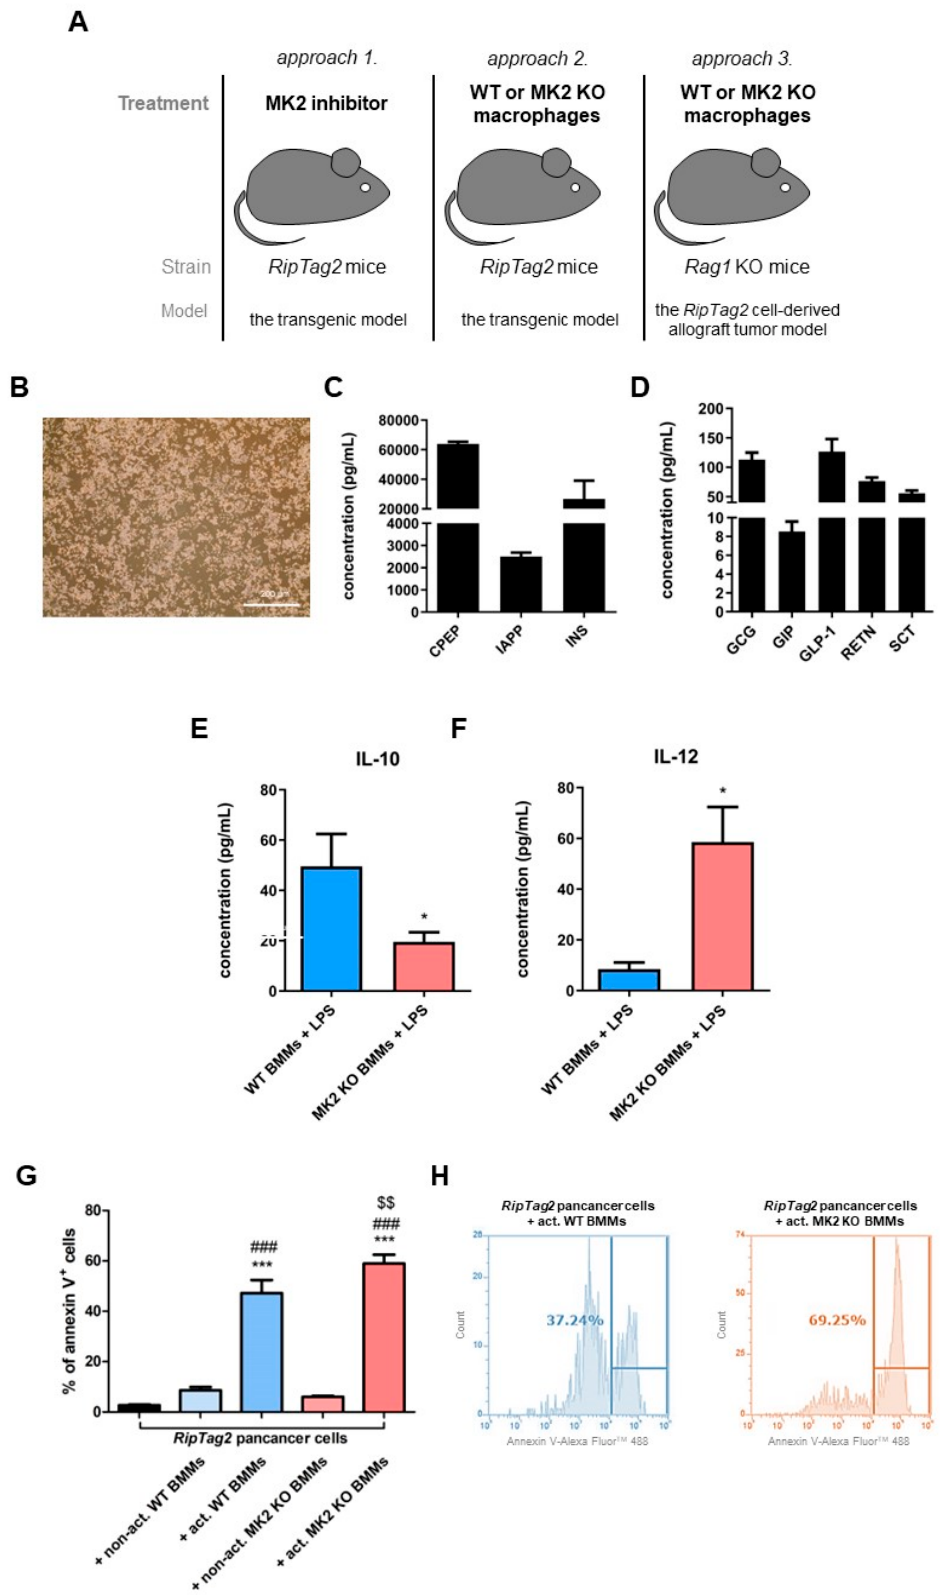
Figure 4. MK2 KO BMMs are anti-tumorigenic in vitro and in vivo. In vitro studies in the transgenic and the RipTag2 cell-derived allograft tumor models were performed ( A ). Tumor cells ( B ) were plated and cultured from a dissociated RipTag2 tumor. Cell supernatants were examined with a